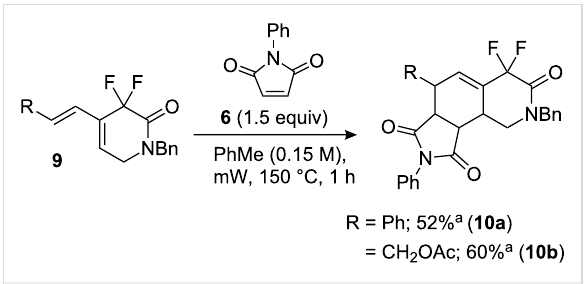
As expected, the Diels–Alder reaction with N -phenylmaleimide 6 gave 6-substituted gem -difluoroisoquinolinones efficiently with slight stereoselectivity (Scheme